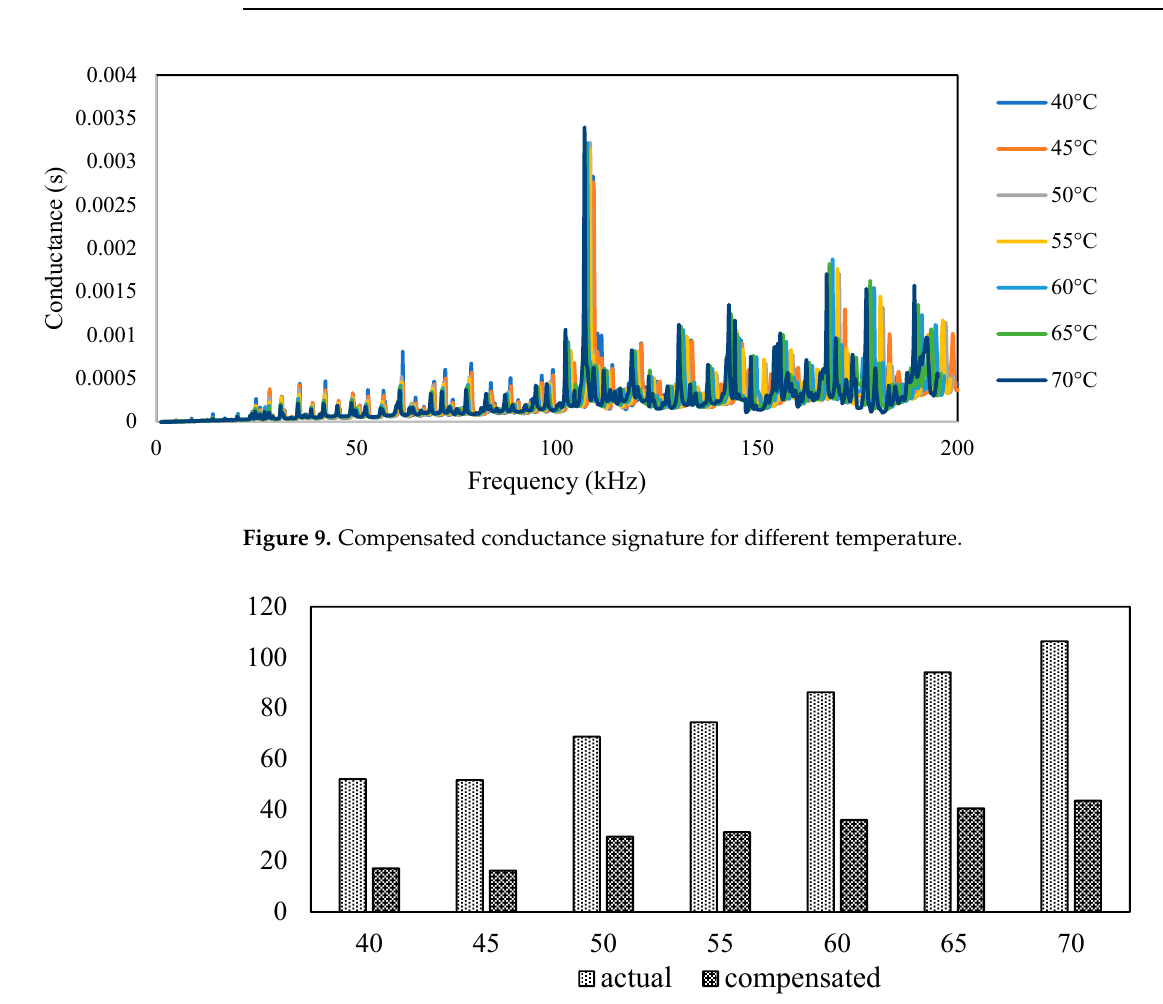
Figure 10. RMSD index plot of uncompensated and compensated signatures.